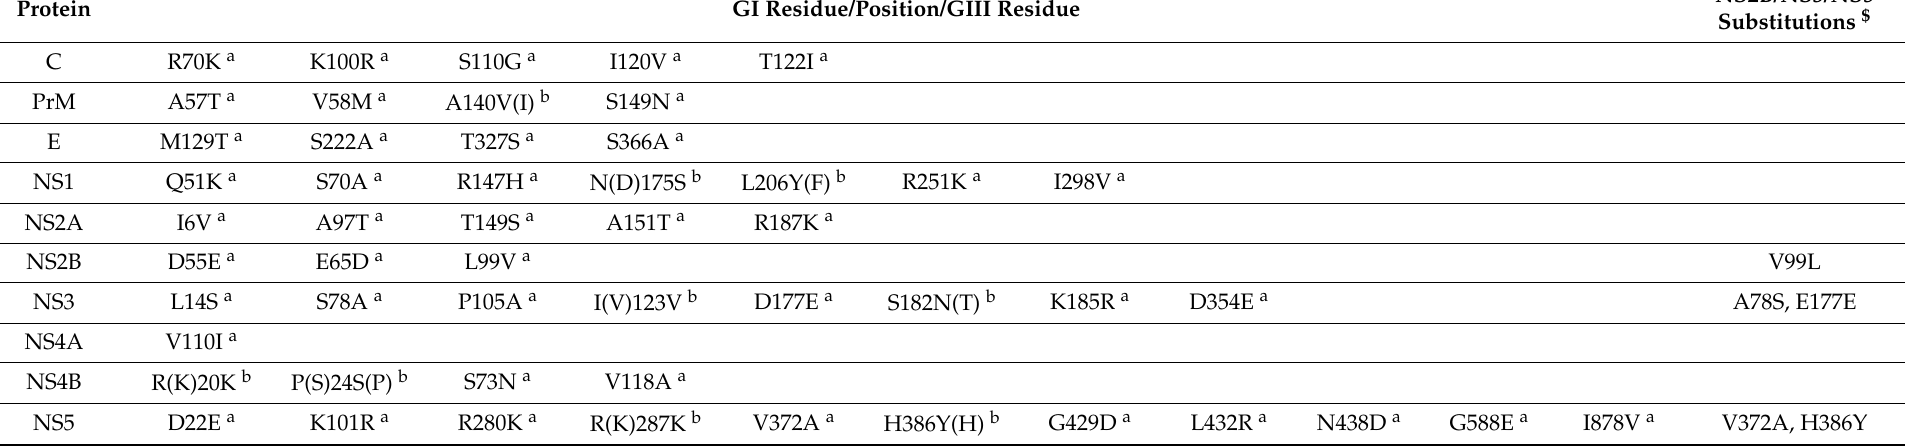
Table 3. The amino acid variations conserved between JEV GI and GIII strains and some key substitutions at NS2B/NS3/NS5 that might be helping GI viruses to adapt reser- voir/amplification host and have effect on JEV